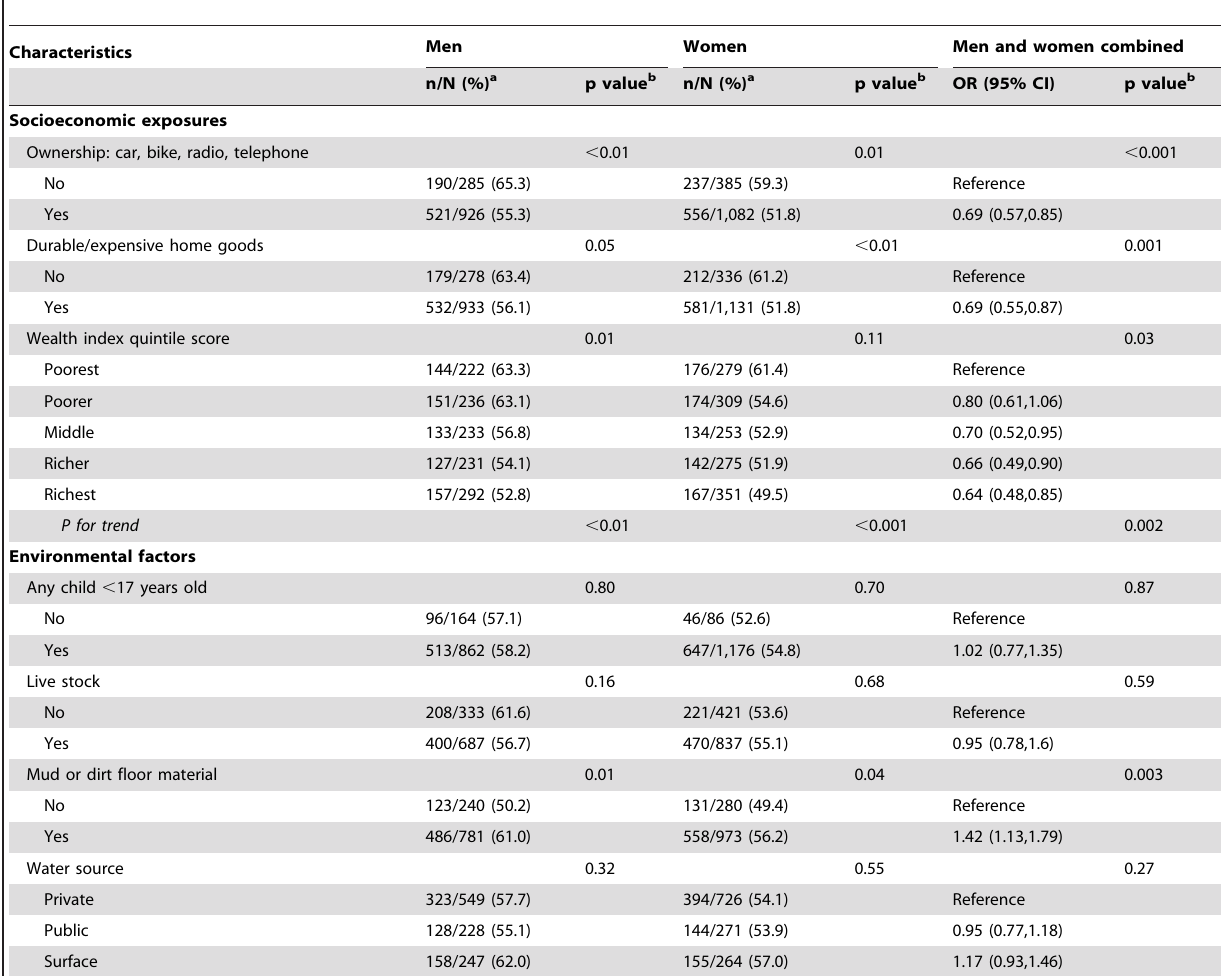
Table 2. Crude association between HHV8 seropositivity and socioeconomic and environmental variables among sexually active adults in